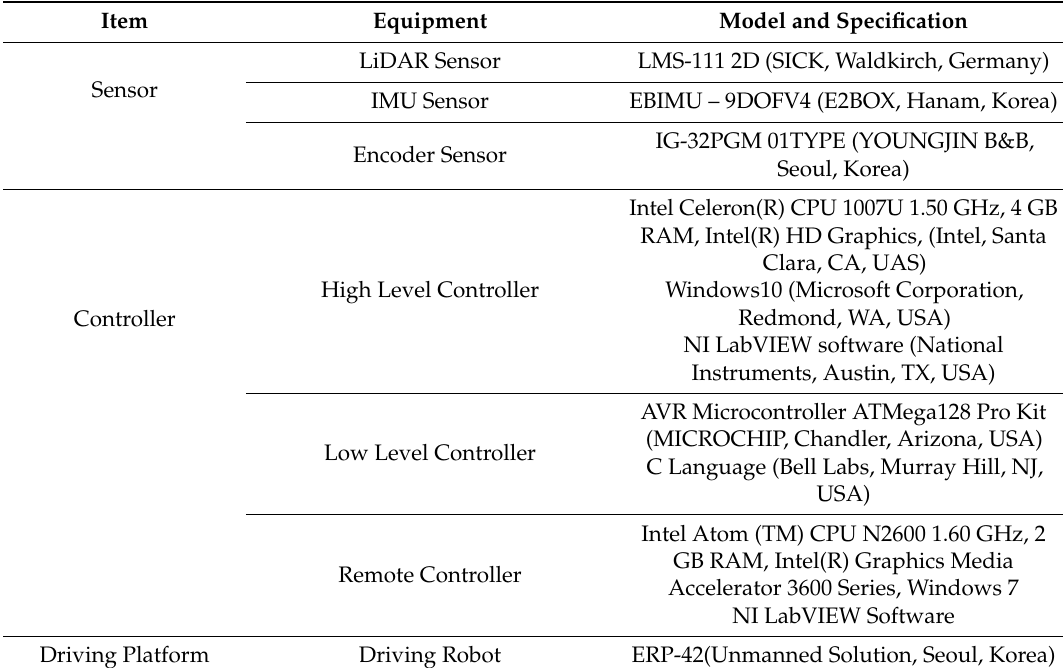
Table 1. Specification of sensors, controller, and driving platform used in this study.